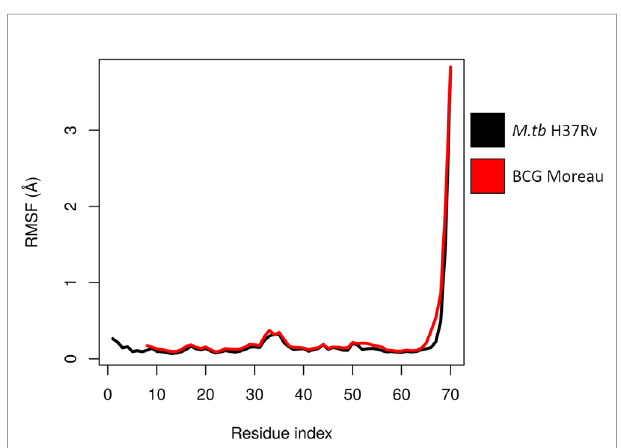
FIGURE 3 | Flexibility of dodecin chain A. The chain A RMSF values calculated from ENM for each complex are shown throughout the protein sequence, suggesting a similar fl exibility pattern between M.tb and BCG Moreau dodecin complexes.